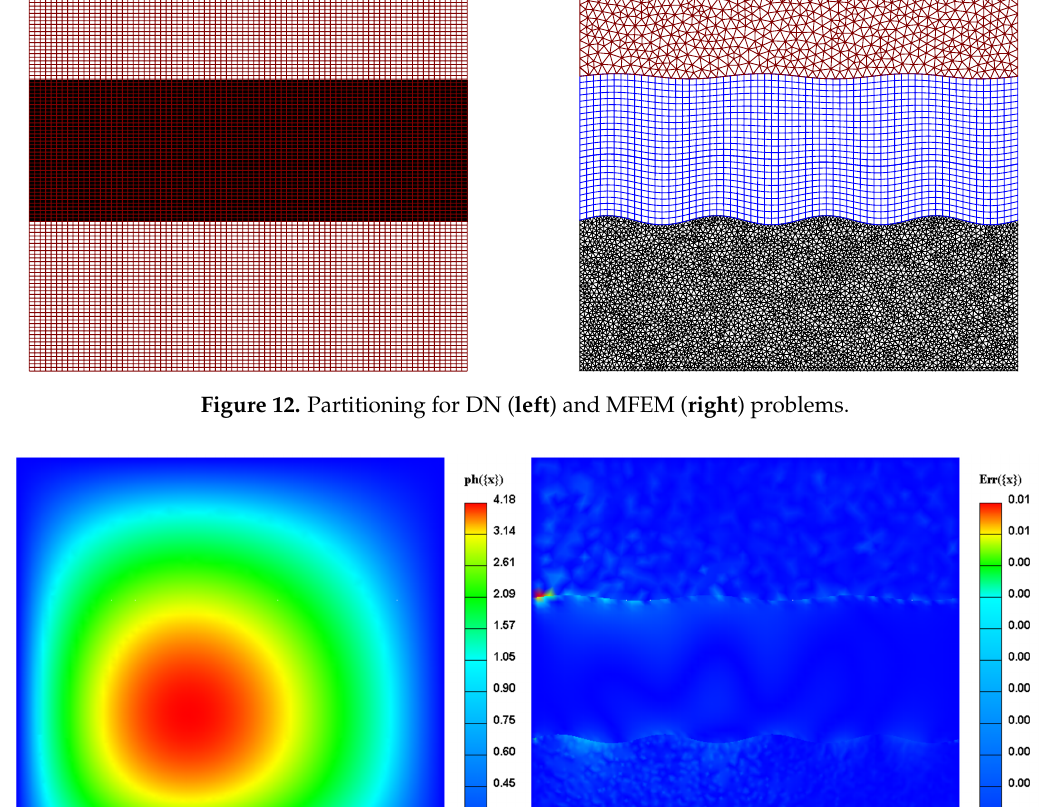
Figure 13. MFEM solution to problem (25) with pressure field (27) ( left ) and its error ( right